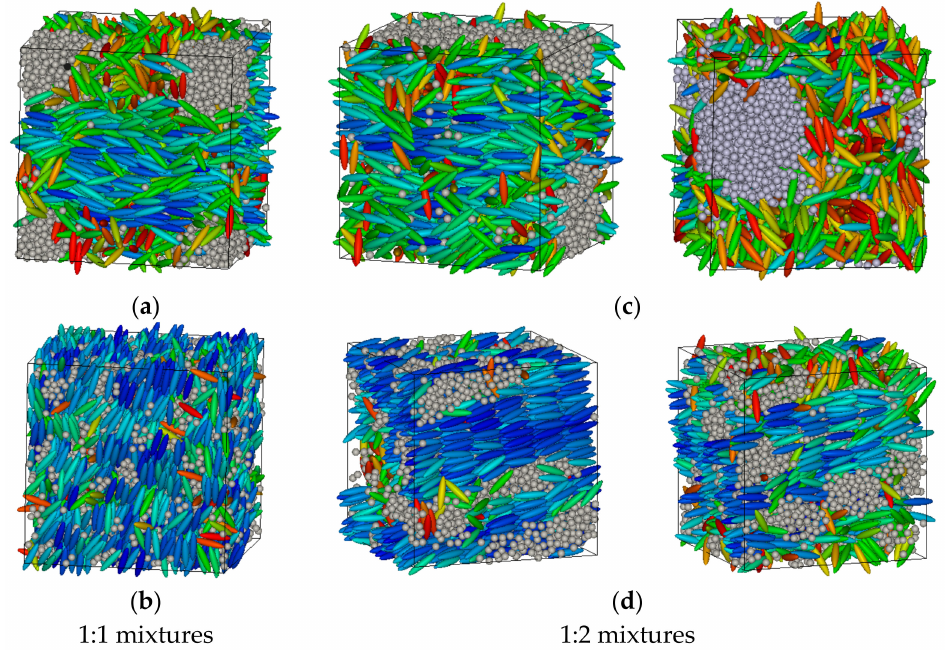
Figure 3. ( a ) 1:1 mixture: phase-separated nematic GB and isotropic LJ: q * = 0.0/ − 0.0, T * = 1.10; ( b ) 1:1 mixture: ionic LC phase with incipient smectic layering of the GB particles: q * = 0.50/ − 0.50, T * = 0.65. ( c ) 1:2 mixture: phase separated GB and LJ particles: q * = 0.0/ − 0.0, T * = 1.10 (left snapshot) and T * = 1.30 (right snapshot); ( d ) 1:2 mixture: microphase segregation GB and LJ particles: q * = 0.50/ − 0.25, T * = 0.65 (left snapshot) and T * = 0.70 (right snapshot), with GB particles arranged in layers. Packing fraction η * =